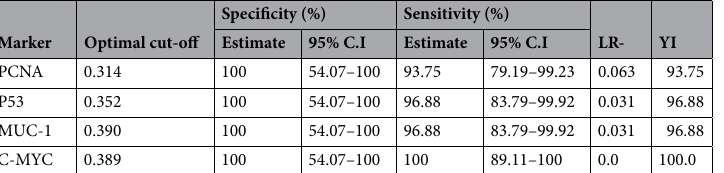
Table 3. Optimal cut-off values of the four studied AAbs and their corresponding for sensitivity (%), specificity (%), negative likelihood ratio (LR-), and Youden’s index (YI). No positive likelihood ratio (LR +) values because all specificity values were 100%. 95%C.I. = 95% confidence